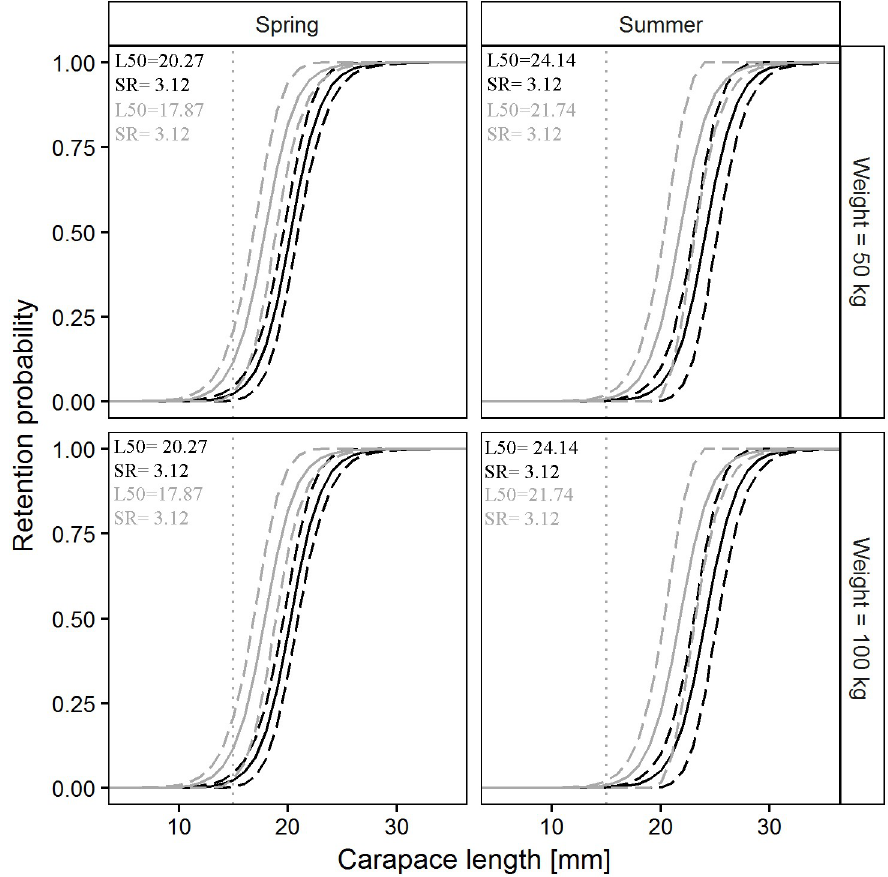
Fig 7. Differences in Norway lobster retention probability between the SM40 (black) and the DM50 (grey) codend in four simulated scenarios. Dashed lines: 95% CI for the mean curve (solid line); dotted vertical line: MCRS for Norway lobster (CL, 20